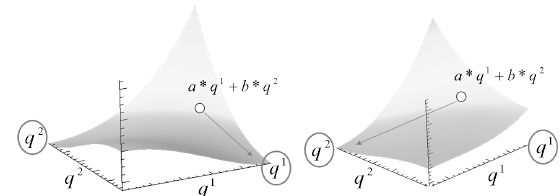
Figure 1: Energy function E ( q 1 , q 2 ) , for two prototypes q 1 , q 2 in the order parameter domain and behaviour of a test vector pro- jected on the plane in the parameter domain. The test vector is attracted towards a stable focus, corresponding for a final state for the vectors q 1 or q 2 (circled in the figure). The final state in the two images differs as the attention parameters are changed. In the second image the parameter λ , associated to the vector q 1 , q 1 Figure 2: Prototype vectors as normalized spectra collected from has been drastically decreased, and the test vector is then attracted a HyMap scene (water, grass, and railroad), plus reconstruction by the final state associated to the vector q 2 . of a test vector (roof) as a linear combination of the prototype vectors.